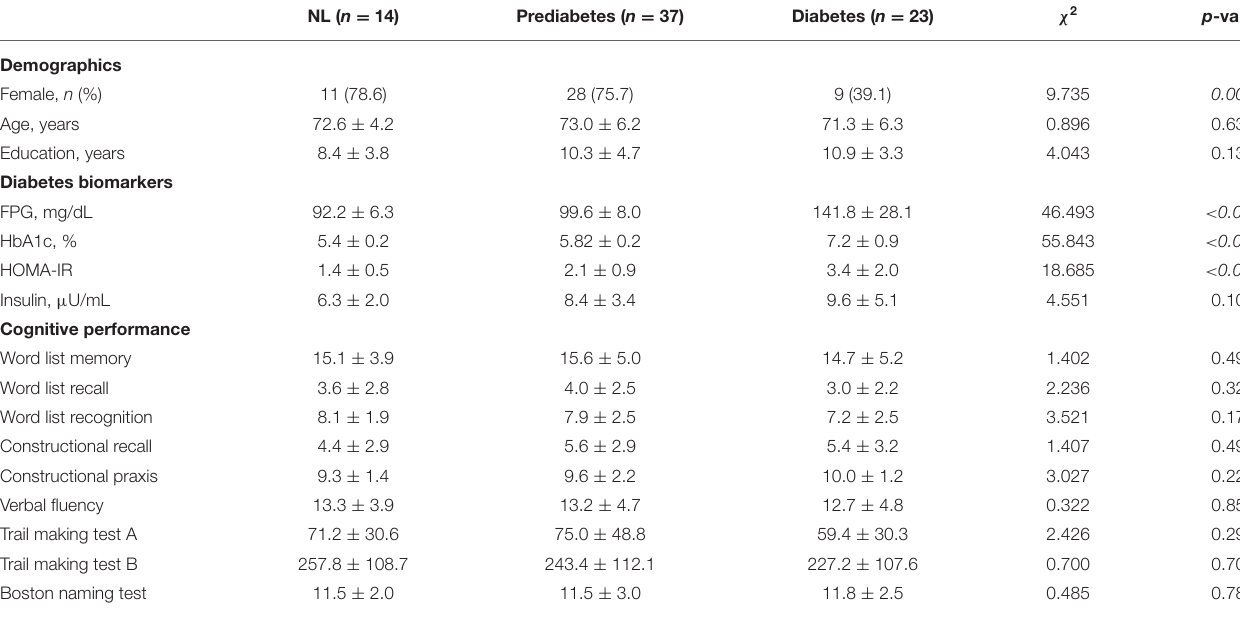
TABLE 1 | Demographic and clinical characteristics of subjects * .